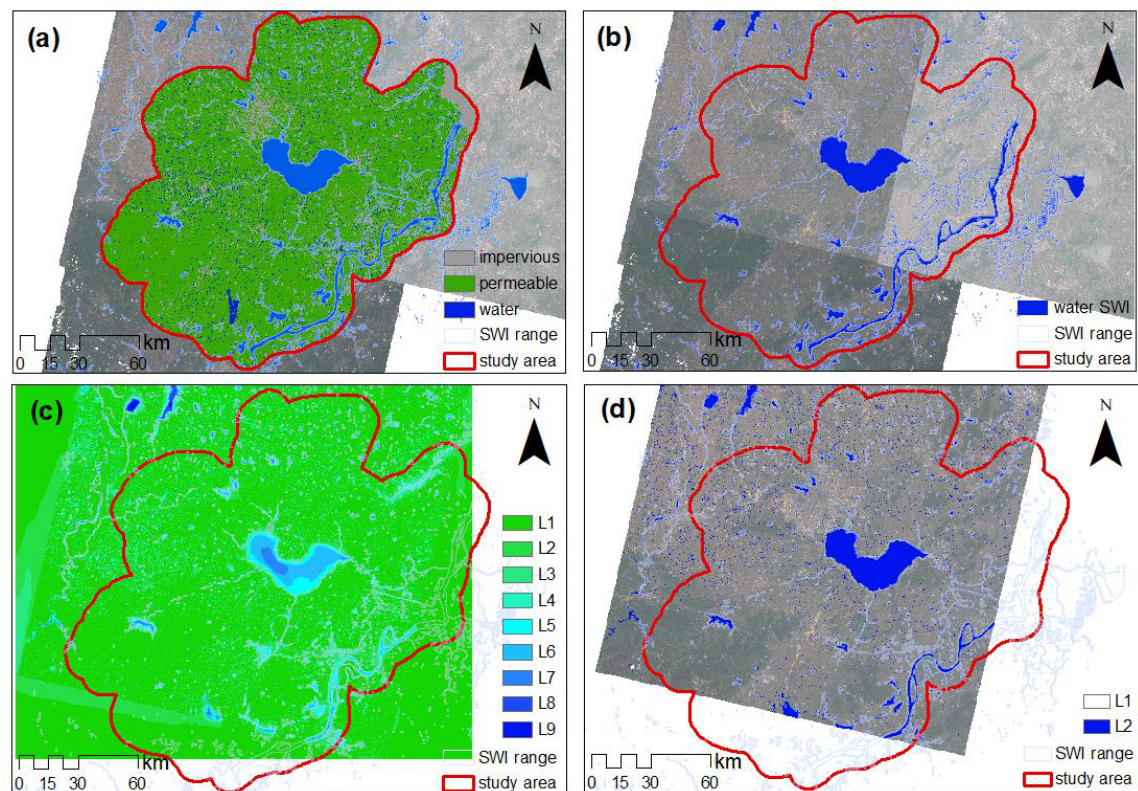
Figure 16. The normal water range extract by the proposed SWI and the RivaMap. ( a ) was the range of water bodies extracted by SWI overlay the distribution of the impervious surface production, ( b ) was the water body and range areas of SWI, and ( c , d ) were the distributions of the multiscale singularity index of RivaMap classified by nature break method as nine types and two types.